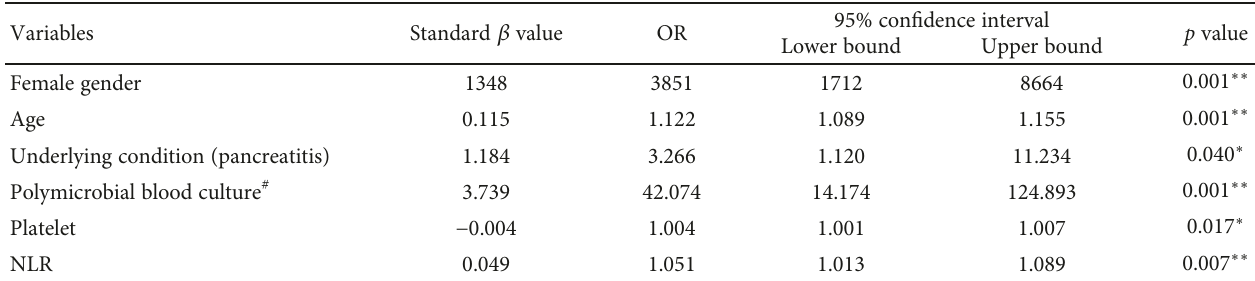
Table 6: Independent predictors of lethal outcome by multivariate logistic regression analysis in all